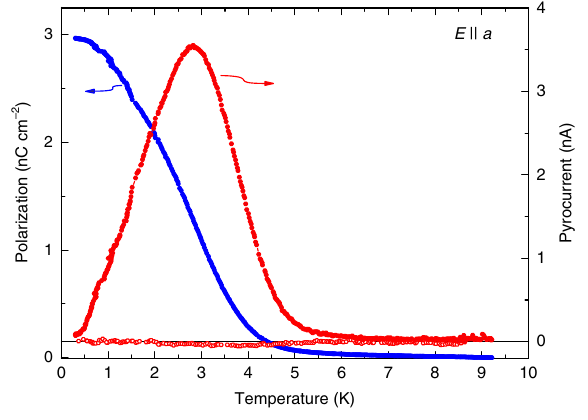
Fig. 4 Pyrocurrent and polarization indicate a phase transition at T 0 = 3 K. Temperature dependences of pyrocurrent (red) measured for E || a polarization while heating in zero electric fi eld after cooling hydrous cordierite crystal in external electric fi eld 8 kVcm − 1 . The temperature- dependent polarization (blue) was calculated from pyrocurrent. Open dots correspond to the pyrocurrent measured during heating in zero electric fi eld after cooling the crystal in zero fi